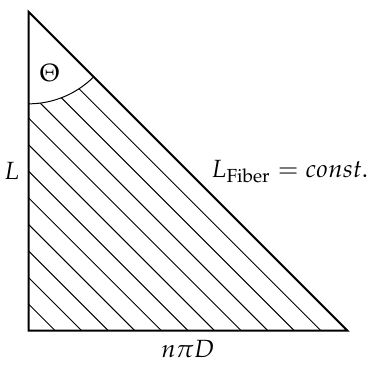
Figure 3. Unreeled membrane of